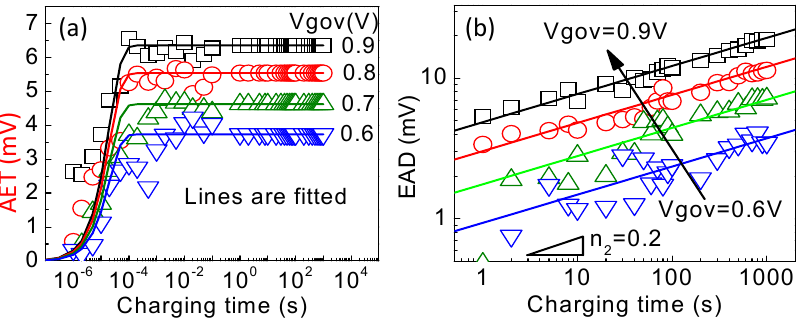
Figure 48. The AG model extracted from the accelerated PBTI tests can predict the PBTI at low biases, while the power law directly fitted with the same test data overestimates PBTI lifetime by 4 orders of magnitude [39]. The stress–discharge–recharge (SDR) technique in Figure 26 can also be applied to PBTI. After removing the contribution of as-grown defects, Figure 49a shows that the power exponent extracted from the generated defects measured by the SDR technique became independent of the measurement conditions. Moreover, Figure 49b shows that the power exponent was insensitive to the stress bias. Figure 49. ( a ) The generated defects measured by the SDR technique were independent of the measurement conditions. ( b ) The GD kinetics under different stress Vgov. The power exponents were insensitive to Vgov [39].